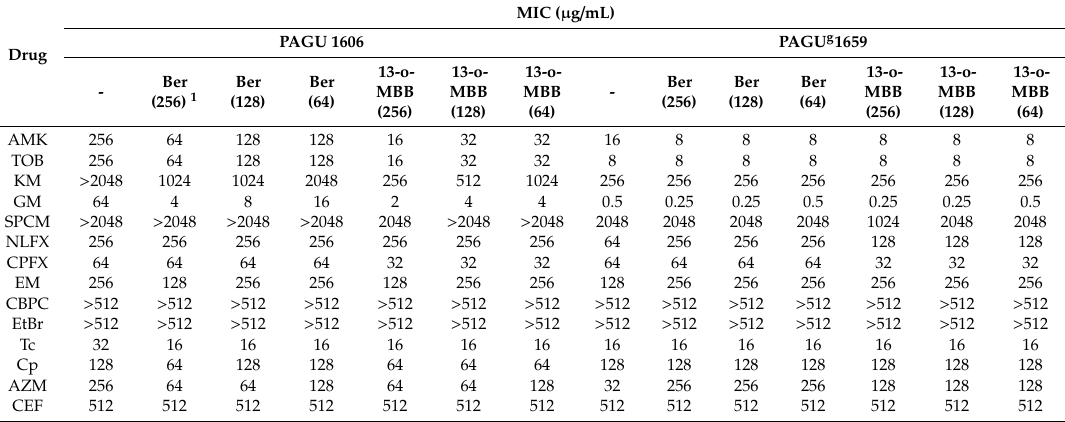
Table 4. Inhibited resistance to aminoglycoside-based drugs by 13-o-MBB in PAGU 1606